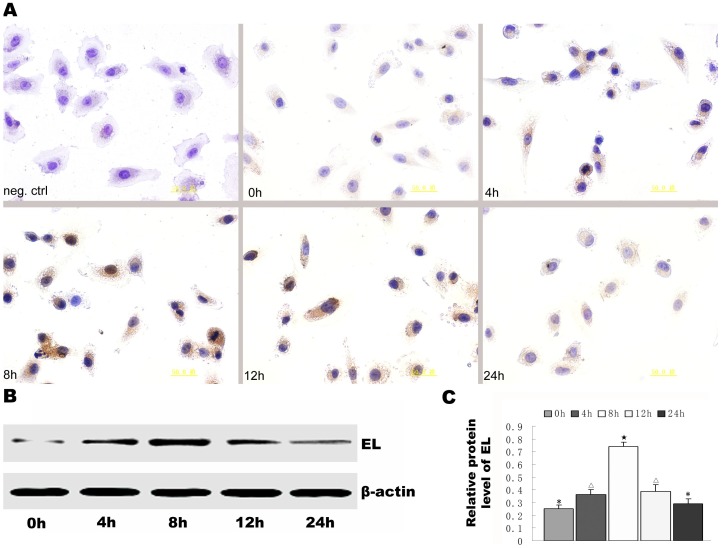
AngII treatment was shown to increase EL expression in HUVECs by immunocytochemical staining and Western blot analyses.(A) Negative control and the immunocytochemical staining of EL at 0 h, 4 h, 8 h, 12 h and 24 h after AngII treatment. (B) EL expression detected by western blotting at 0 h, 4 h, 8 h, 12 h and 24 h after AngII treatment. (C) Semi-quantitative analysis of the EL levels detected by western blotting. Different symbols represent statistical significance (p<0.05).